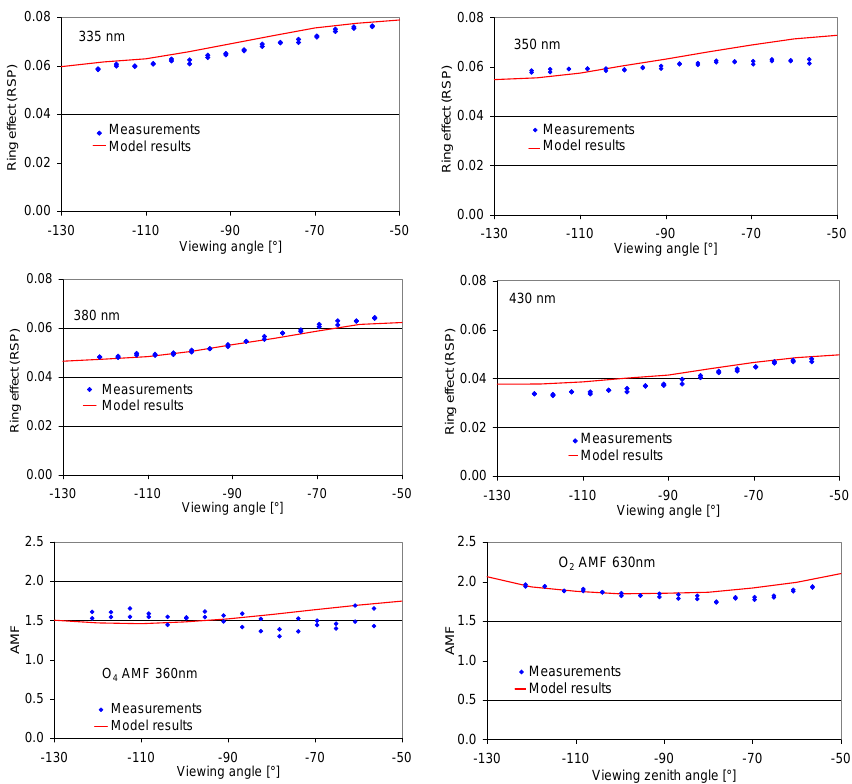
Fig. 8 Observed (blue dots) and modelled dependency of the Ring effect and the O 4 and O 2 absorption on the viewing angle for selected cloud-free observations (results of two consecutive SCIA scans) over Eastern Europe (September 17., 2006, see Fig. 7). The deviations of the measured O 4 and O 2 absorptions from the simulated values are probably related to variations of the surface albedo. For the radiative transfer calculations the following parameters were assumed: surface albedo: 3%, the aerosol layer: 0-1km; aerosol SSA: 0.95; g: 0.68, AOD: 0.05 (630 nm) and 0.1 (all other wavelengths). A viewing angle of –90° indicates nadir viewing geometry. Note that the simulated O 2 AMFs were corrected for the saturation effect (see section 3).